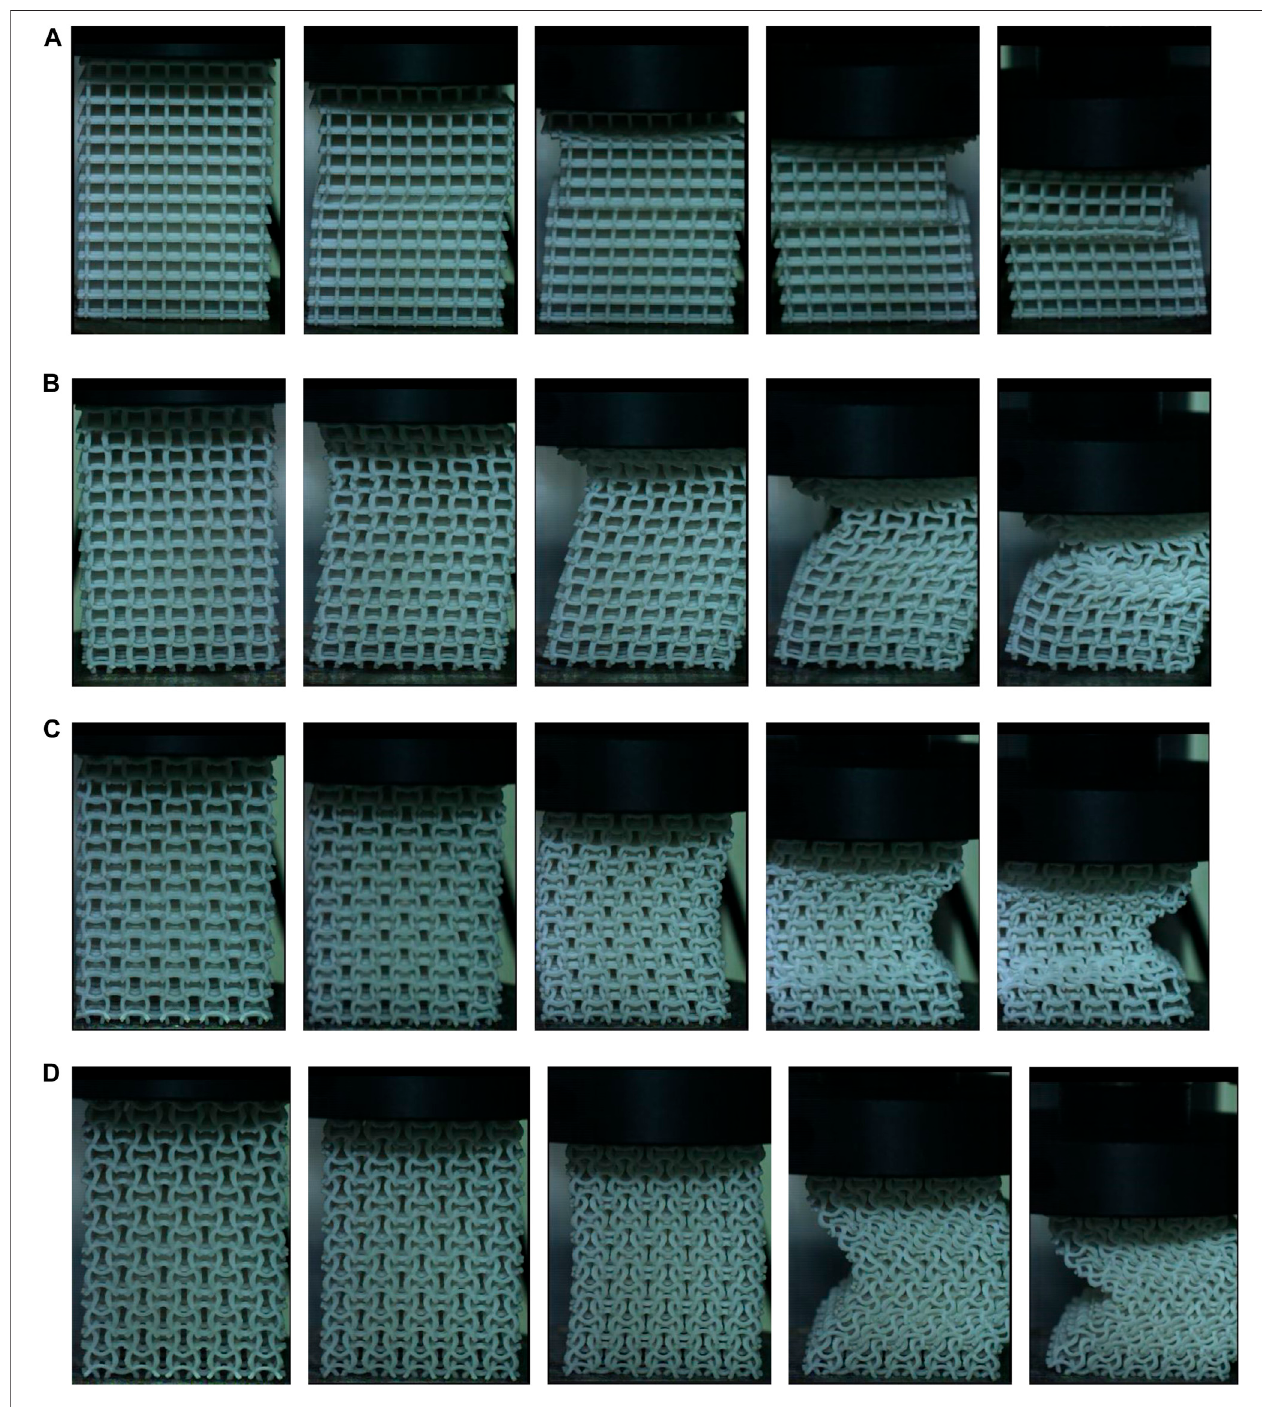
FIGURE 10 | The deformation patterns for the four types of specimens under quasi-static: (A) COF0, (B) CCF1, (C) CCF2, (D) CCF3.